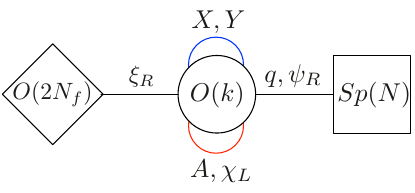
Figure 2 . The 1d N = (0 ; 4) theory for the 5d Sp( N ) with an antisymmetric hypermultiplet and N f fundamental